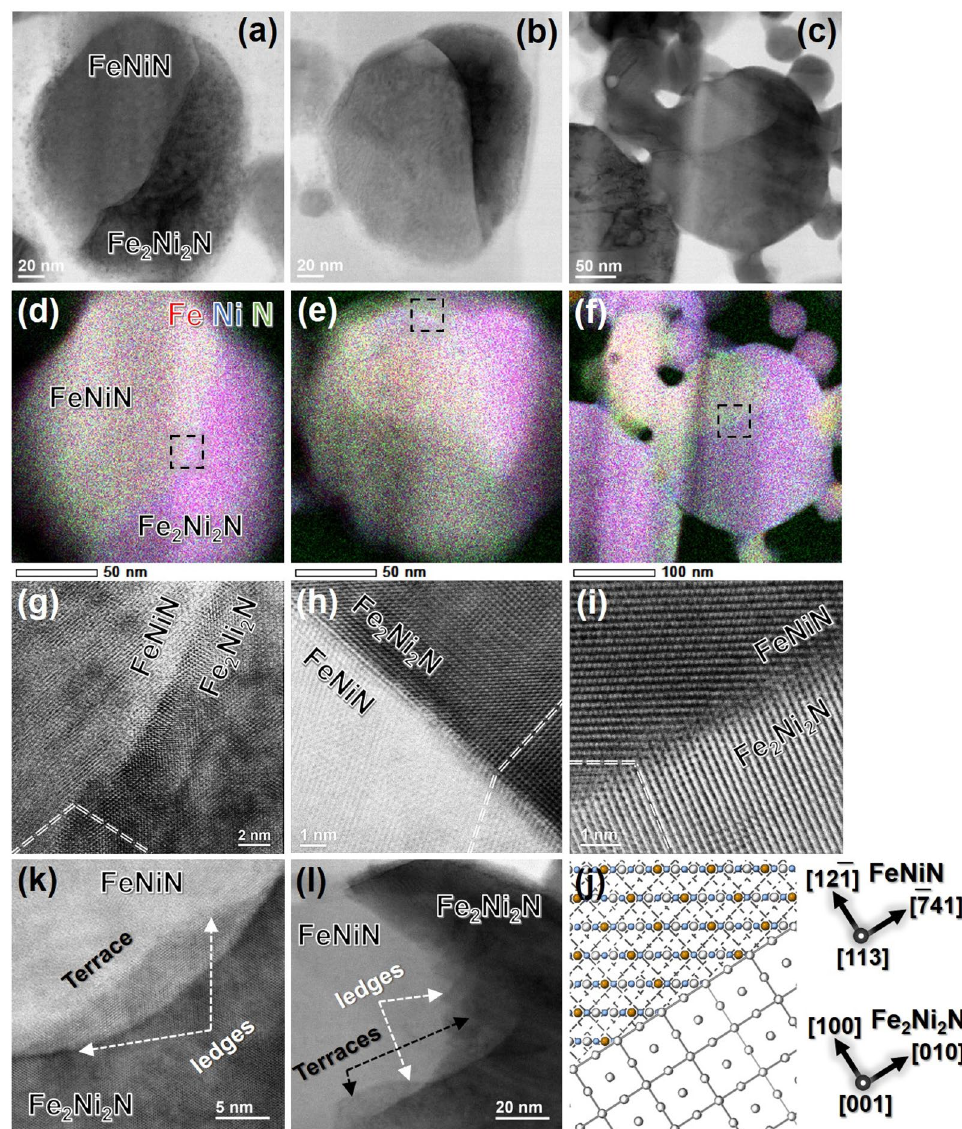
Figure 5. Coherent/incoherent Fe 2 Ni 2 N/FeNiN phase interfaces with ledgewise growth features. ( a–c ) ABF- STEM images and ( d–f ) the corresponding combined (Fe, Ni, and N) elements distribution mapping of the nitrided FeNi NPs. ( g–i ) High-resolution ABF-STEM images focusing on the detailed microstructure of the FeNiN/Fe 2 Ni 2 N interfaces. The observed areas are indicated by the dashed squares marked in the corresponding element distribution maps ( d – f ). The high-index/irrational OR developed at the FeNiN/Fe 2 Ni 2 N coherent ( h )/ incoherent ( g , i ) interfaces were indicated by the dashed line and one representative high-index orientation relationship present in ( i ) is schematised in ( j ). ( k , l ) ABF-STEM images of nitrided FeNi NPs with terraces/ ledges demonstrating the ledgewise growth motion of the FeNiN/Fe 2 Ni 2 N phase interface in ( a ) and ( c ),